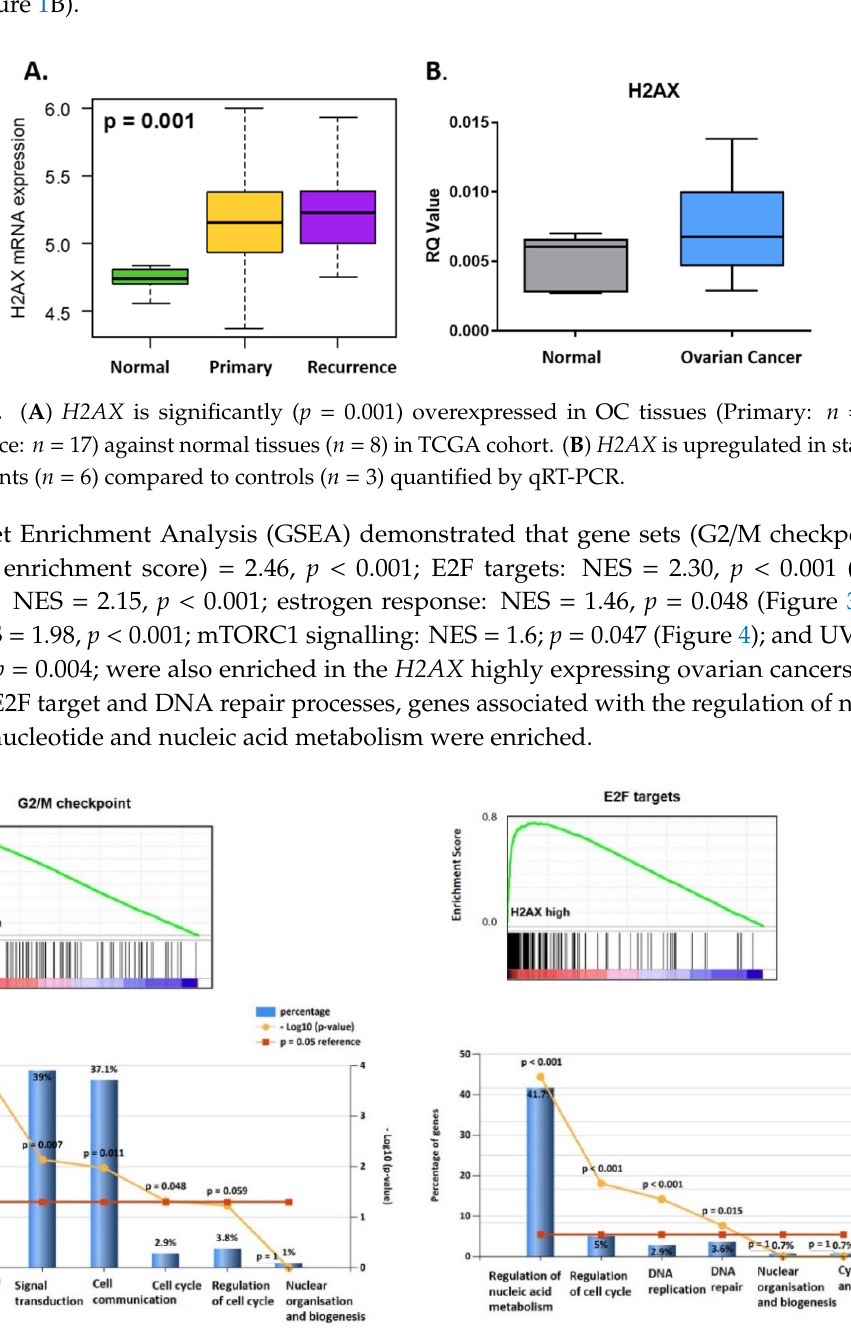
Figure 2. Gene enrichment on genes significantly associated with G2 / M checkpoint, E2F targets, with significant biological processes of regulation of nucleic acid metabolism, signal transduction and cell communication for the G2 / M group, and regulation of nuclei acid metabolism and cell cycle as well as DNA replication and repair for the E2F cohort.